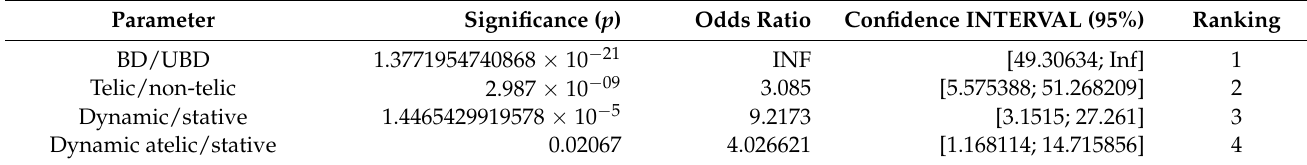
Table 13. Summary of quantitative findings, and ranking of parameters for temporal